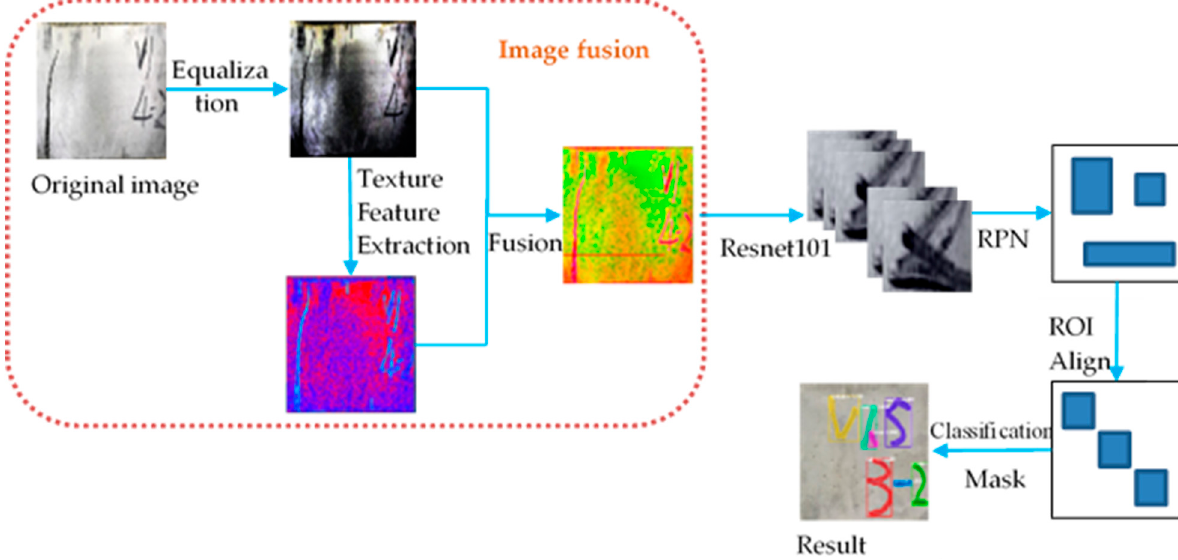
Figure 1. Flowchart of the proposed method for crack detection of concrete images.